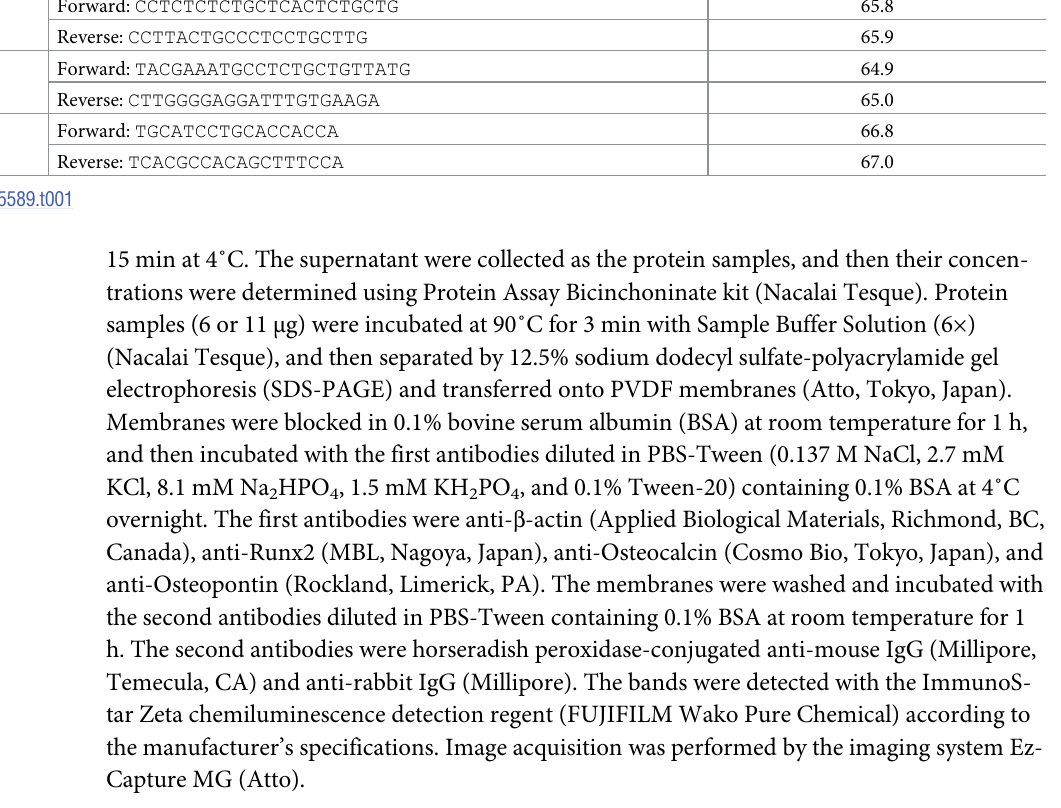
Table 1. Primer sequences for quantitative